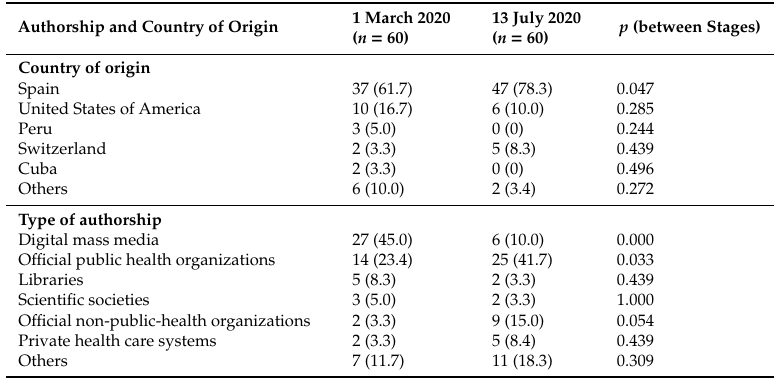
Table 1. Authorship and country of origin of the weblinks by the search